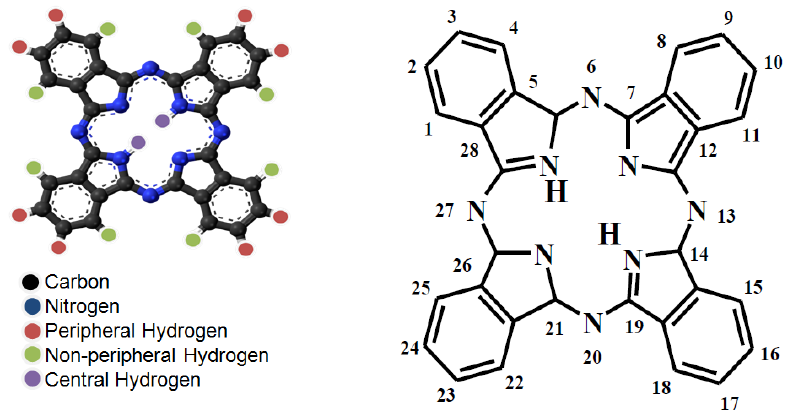
Figure 1. Structure of phthalocyanine.